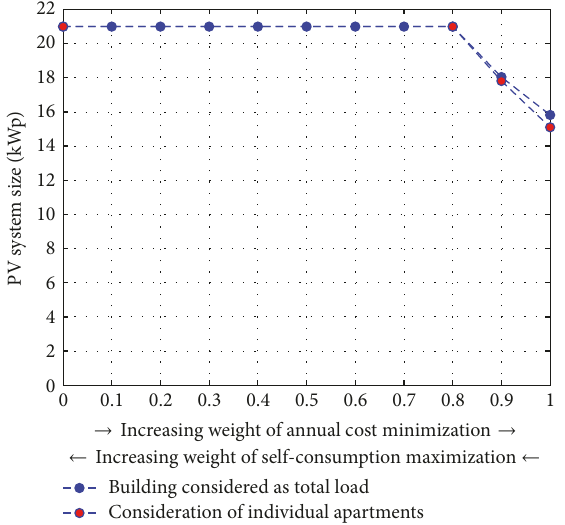
Figure 11: German retail electricity prices: impact of synergy effects between load profiles on the optimal PV peak capacity installed.